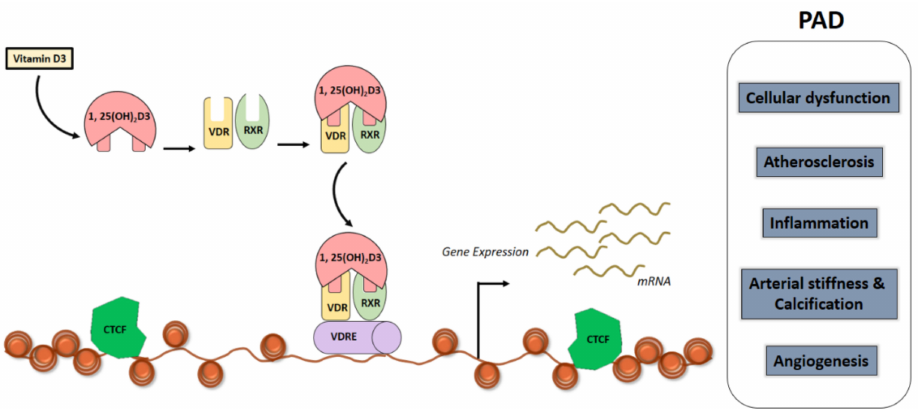
Figure 2. Schematic illustration vitamin D canonical signalling pathway and its role on mechanisms relevant to PAD formation. The biologically active form of vitamin D3 is 1,25(OH) 2 D 3 , is a ligand for a nuclear transcription factor VDR. VDR is present in most cell types and once the VDR is bound with